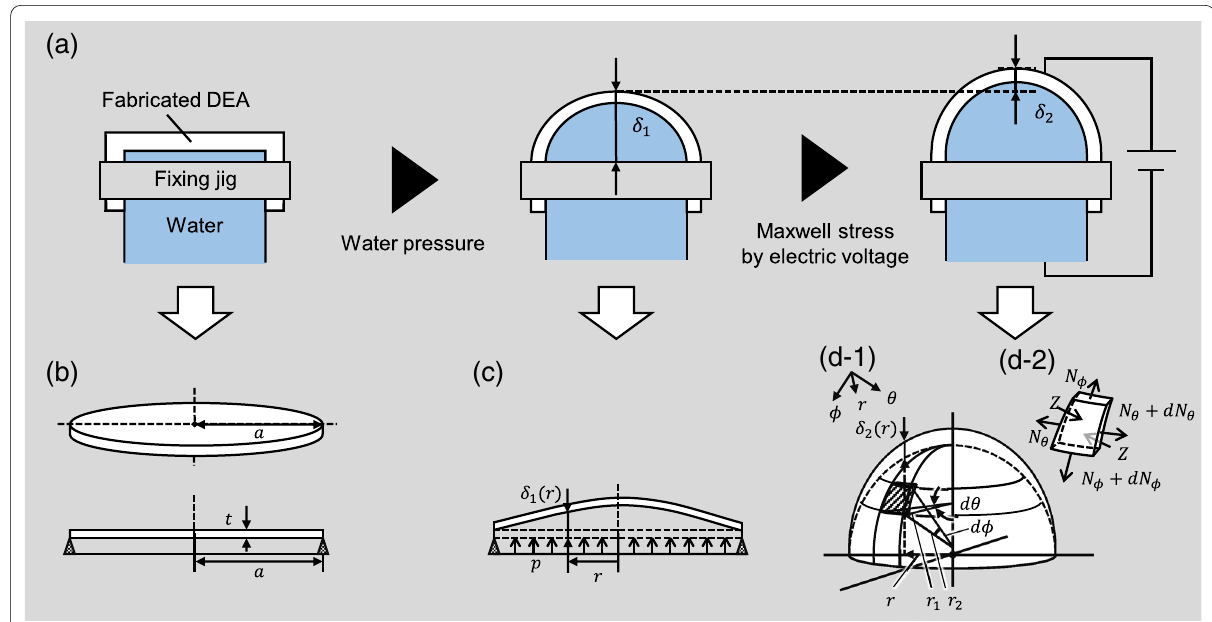
Fig. 4 Analysis model of DEA prestretched with water pressure. a Schematic of three phases of the DEA, structural mechanics model for: b pre-water pressure application, c post-water pressure application, d post-water pressure and electric voltage